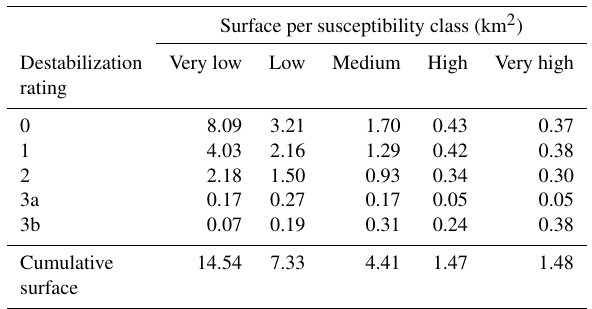
Table 5. Active rock glacier area per class of destabilization sus-